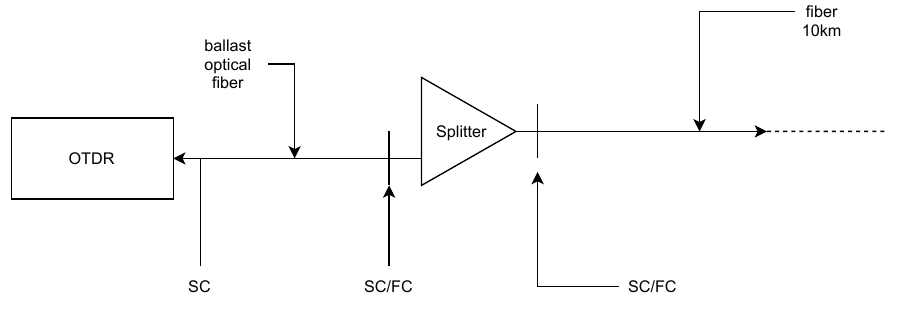
Figure 2. OTDR measurement setup. Table 4. Insertion loss of the coupler 80:20 measured with OTDR method.